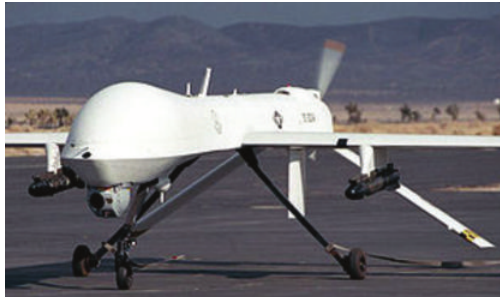
Figure 8: Rotax 914, a four-cylinder, four-stroke, 101-horsepower engine, the same engine type commonly used on snowmobiles, rotates the Predator’s two-blade, variable-pitch pusher propeller